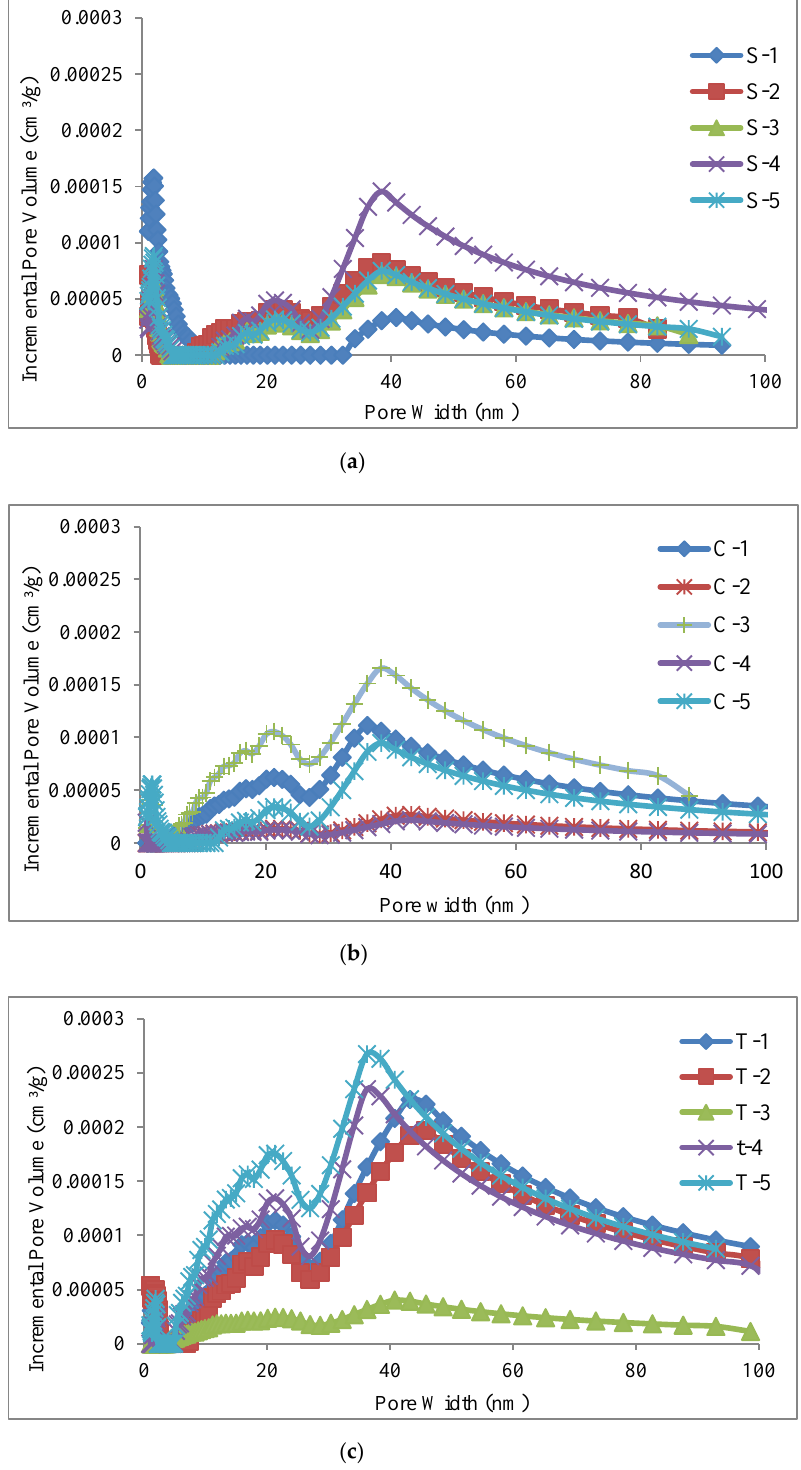
Figure 8. Transitional and micropores coal, shale and tight sandstone samples via LP-N 2 GA. ( a ) Transitional pores and micropores of shale samples via LP-N 2 GA. ( b ) Transitional pores and micropores of high-rank coal samples via LP-N 2 GA. ( c ) Transitional pores and micropores of tight sandstone samples via LP-N 2 GA.